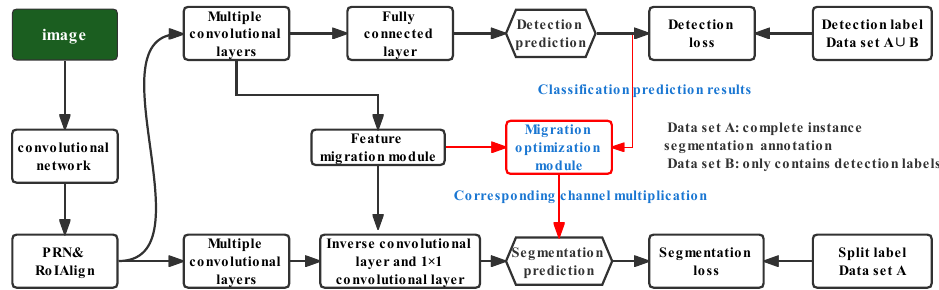
Figure 1. The overall structure of the AFT-Mask